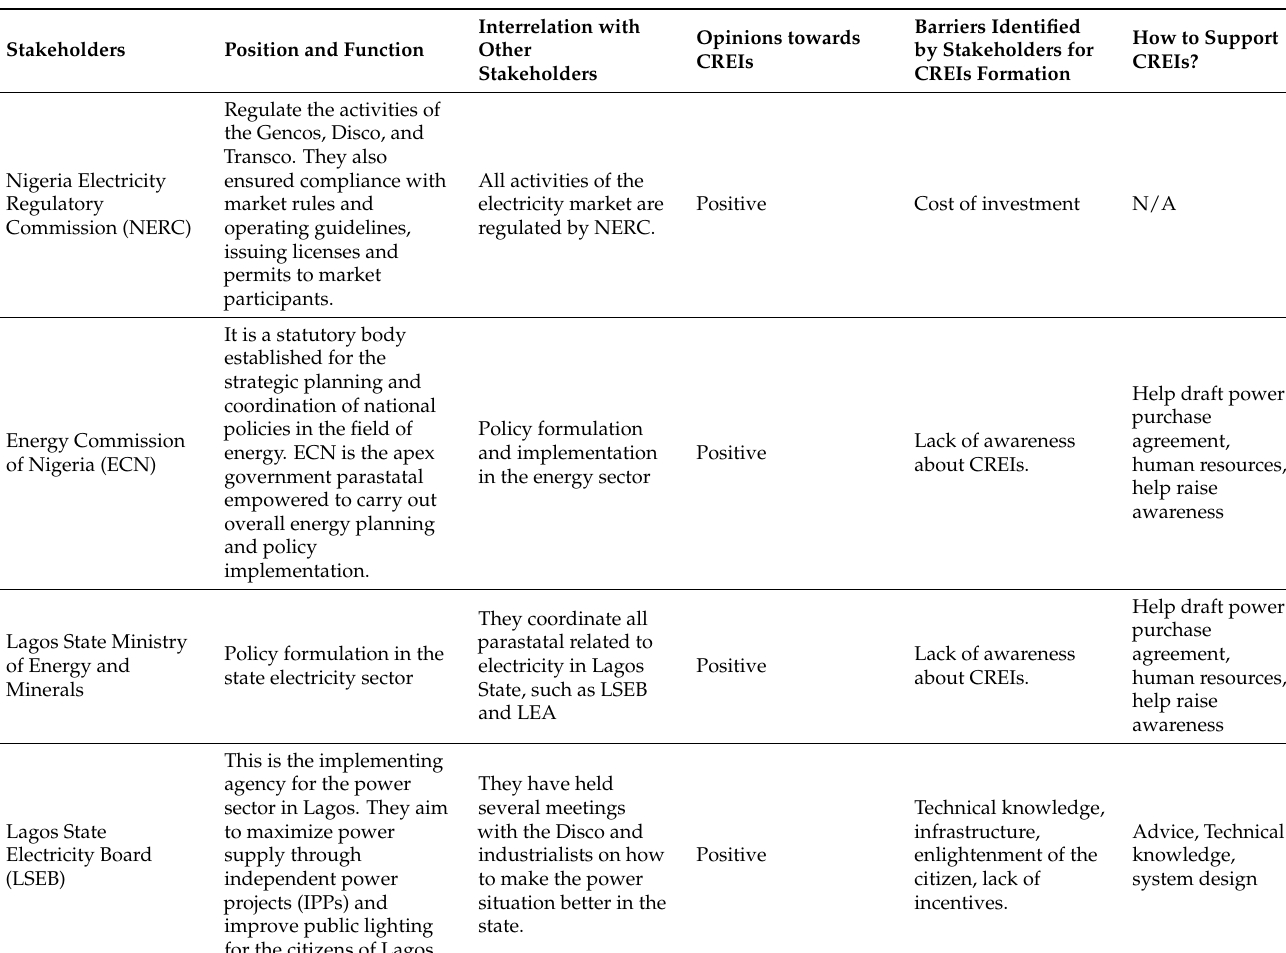
Table 2. Stakeholders, their main characteristics, and views towards